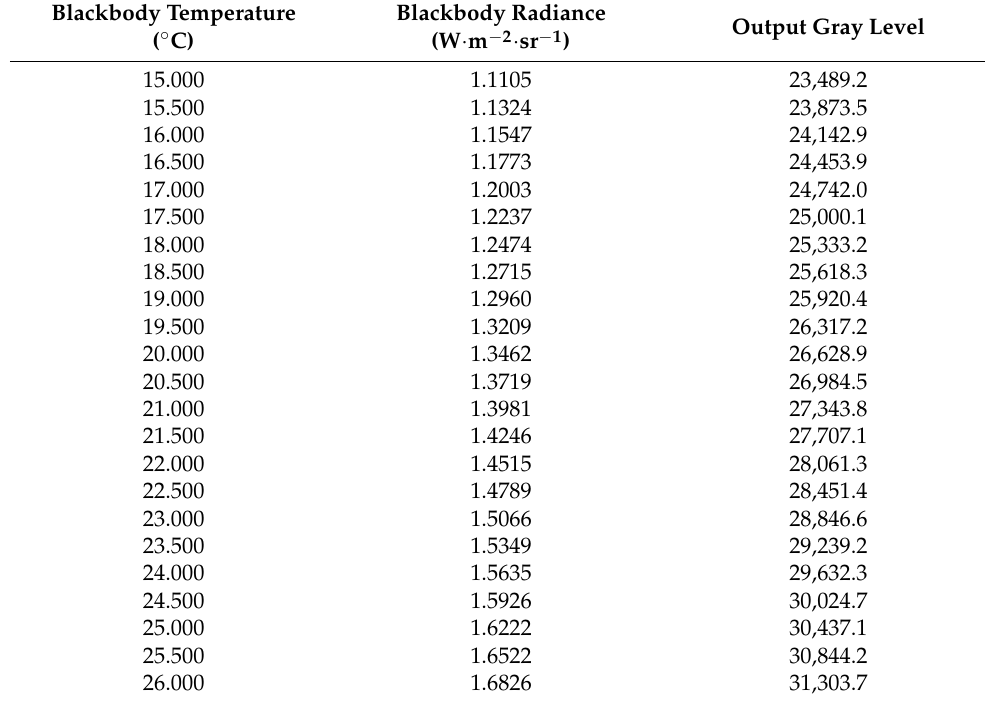
Table 1. Blackbody temperature, radiance, and output gray level of the thermal imager.